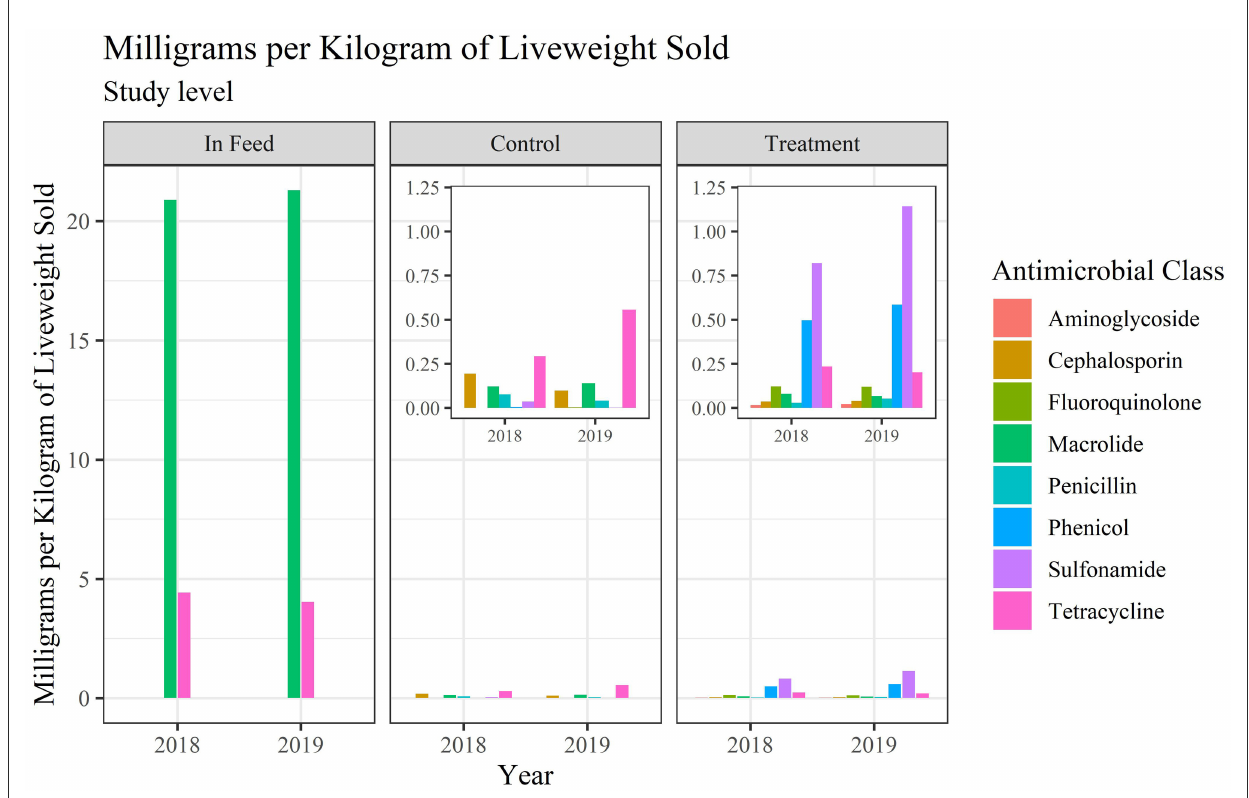
FIGURE4 Milligrams per kilogram-LW for medically important antimicrobials at the study